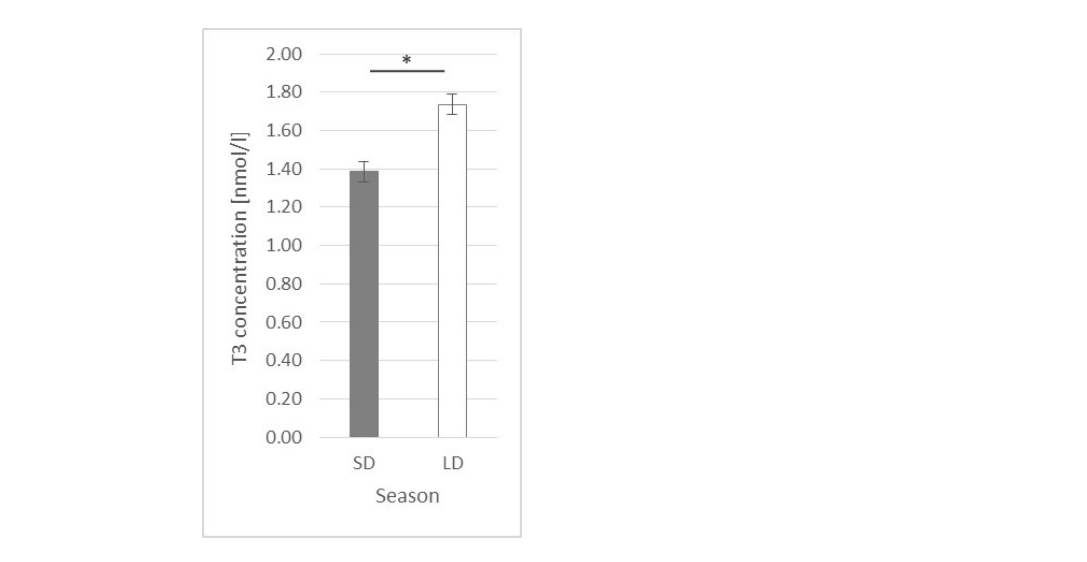
11 of 24 Figure 12. Plasma thyroxine (T4) concentration—comparison among the experimental groups (con- trol, LPS, LEP and LPS + LEP) for the short-day (SD) ( A ) and long-day (LD) ( B ) photoperiods for each selected time point separately; n = 6. Groups: control—saline injection, LPS—lipopolysaccha-